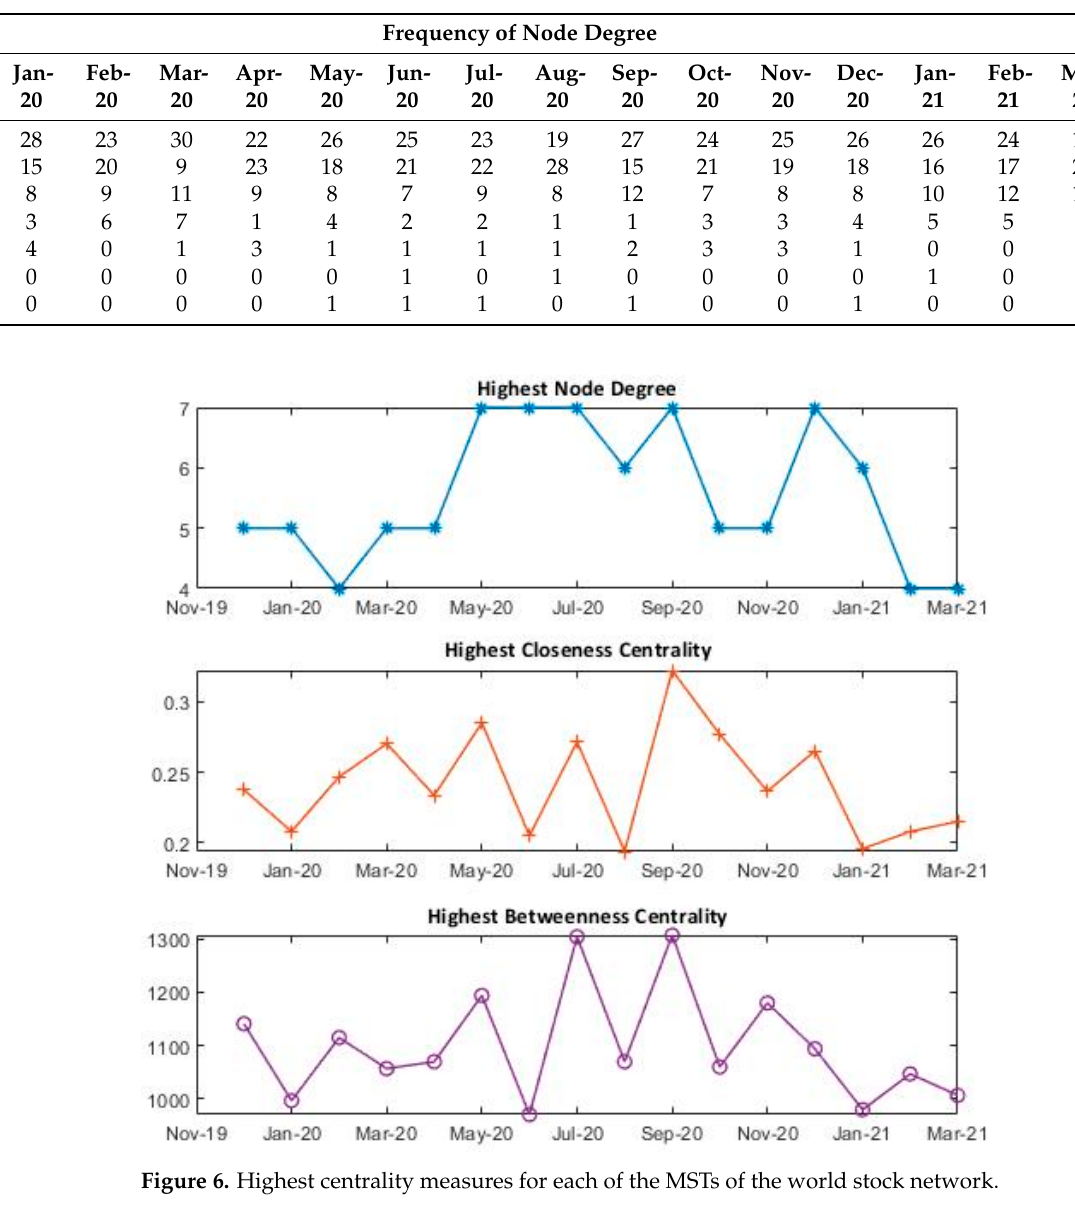
Figure 6. Highest centrality measures for each of the MSTs of the world stock network.